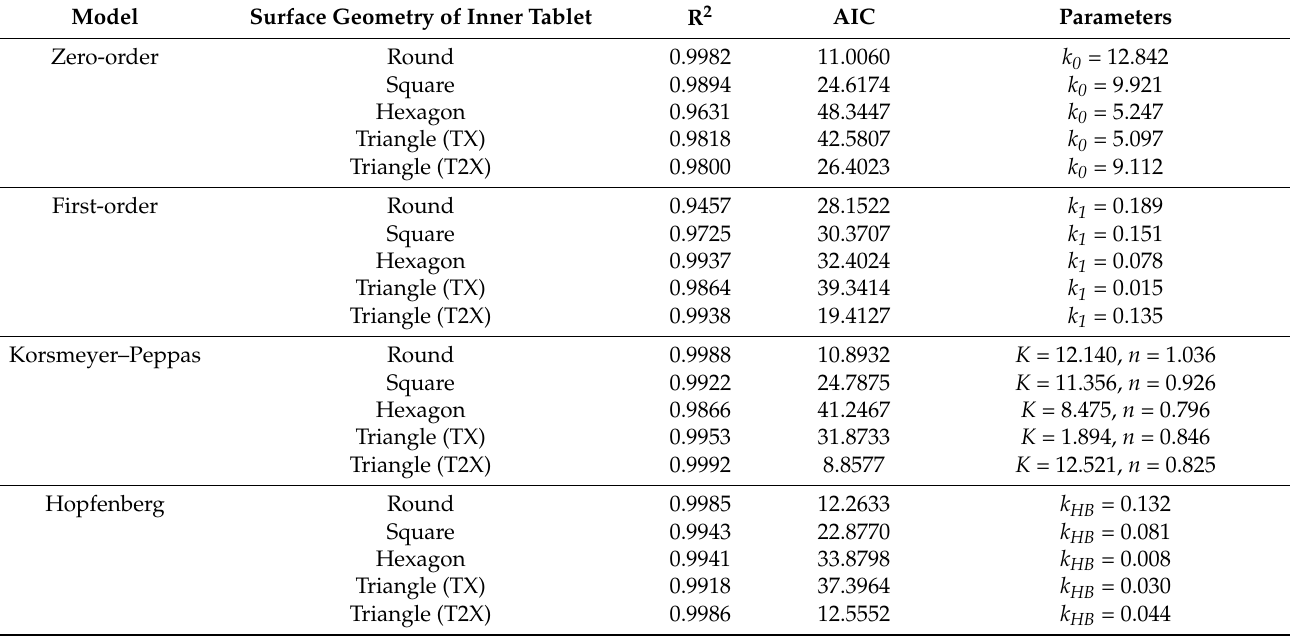
Table 3. Release kinetics of FDP-loaded 3D-printed tablets with different surface